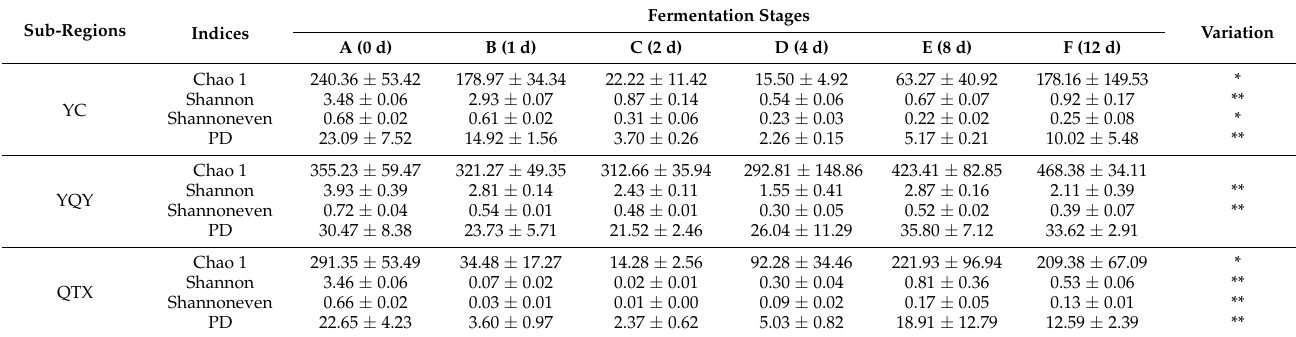
Table 1. Bacterial diversity in different fermentation stages.